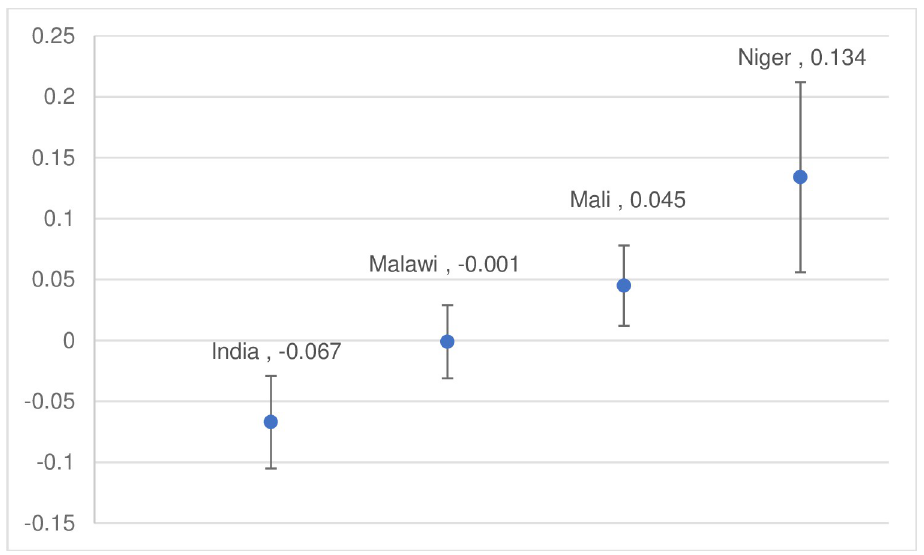
Fig 4. Difference-in difference results for proportion of girls ages 12–19 ever married, baseline to endline.